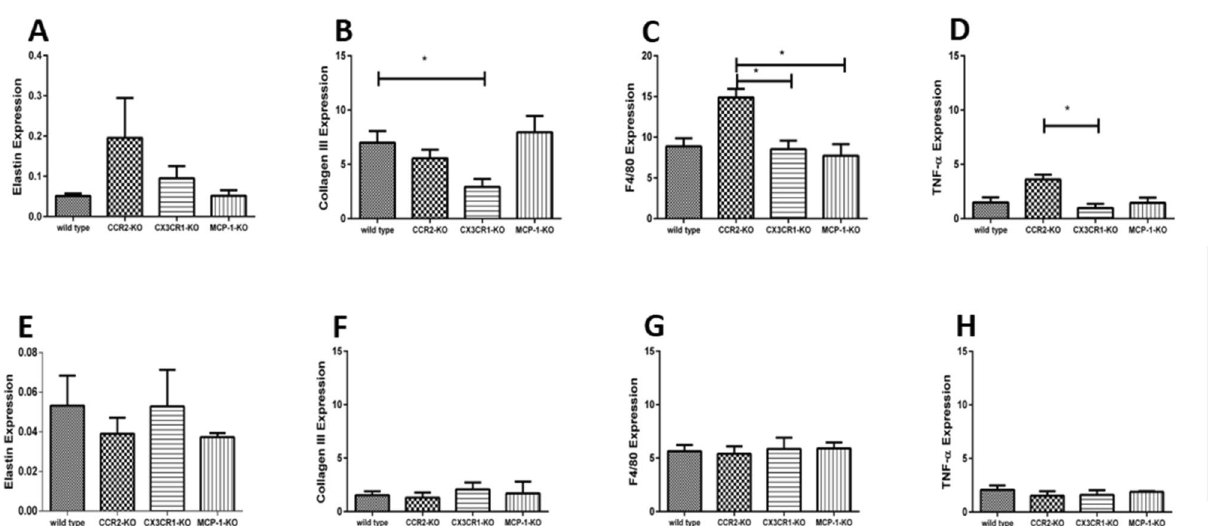
Figure 4. Representation of cardiac remodeling with the aid of gene expression of relevant markers such as elastin 7 days ( A ) and 30 days ( E ) after permanent ligation. Expression of collagen III 7 days ( B ) and 30 days ( F ) after permanent ligation. In ( B ) collagen III-expression was significantly increased in wild-type mice compared to CX3CR1-KO mice, which shows early remodeling in wild type mice, but no statistically relevant difference in functional outcome, ( C ) represents increased monocyte-expression (F4/80) in CCR2-KO-mice compared to CX3CR1-KO mice and to MCP-1-KO mice 7 days, ( G ) shows monocyte-expression 30 days after MI. In ( D ) an increased TNF-alpha gene expression was seen in CCR2-KO mice compared to CX3CR1-KO mice, ( H ) represents TNF-alpha gene expression 30 days after